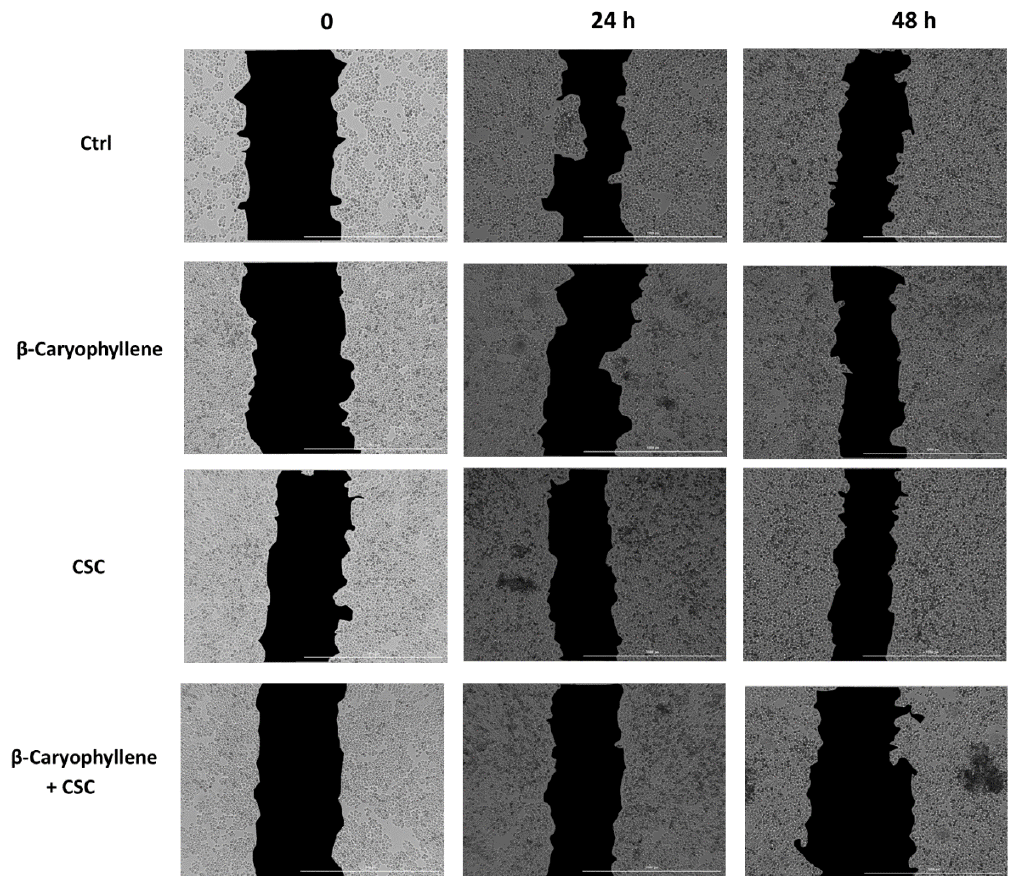
Figure 14. MDA-MB-468 cells migration rate at 0 h, 4 h and 72 h ( n = 3) after co-treatment with β -caryophyllene and cigarette smoke condensate (CSC) in MDA-MB-468 cancer cells. A. Images of wound healing assay captured at each time point and processed by Gen5™ Microplate Reader and Imager Software (Version 3.11, BioTek, AHSI, Milan, Italy) (4 × original magnification). The quantified wound areas are displayed in black. Scale bars = 1000 µ